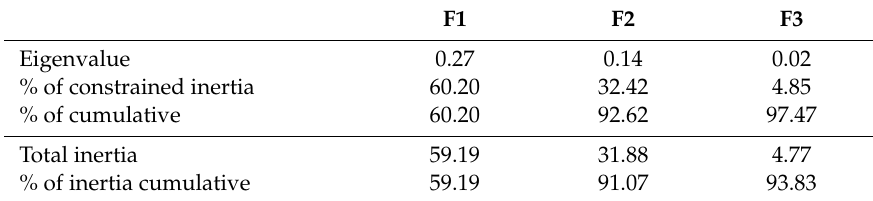
Figure 10. Canonical correspondence analysis (CCA) ordination of major phytoplankton groups and species with physical and chemical parameters in different seasons of the first two axes, F1 = 60.20% and F2 = 32.42%. Only the species well-characterized by the first two CCA components are shown. Table 3. Inter-set correlations of significant environmental factors with the first three ordination axes of the final canonical correspondence analysis (CCA) (abundance sum of squares and pairwise comparisons showed that there were significant differences ( p <0.05) of